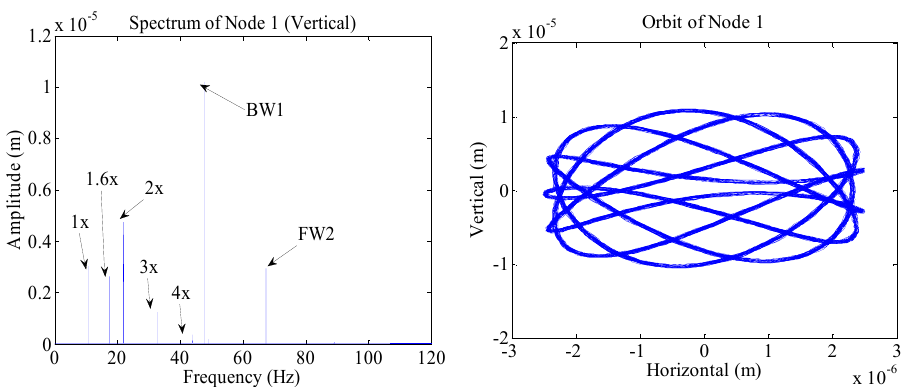
Figure 13. The spectrum and the orbit of Bearing 1 (without bearing damping).